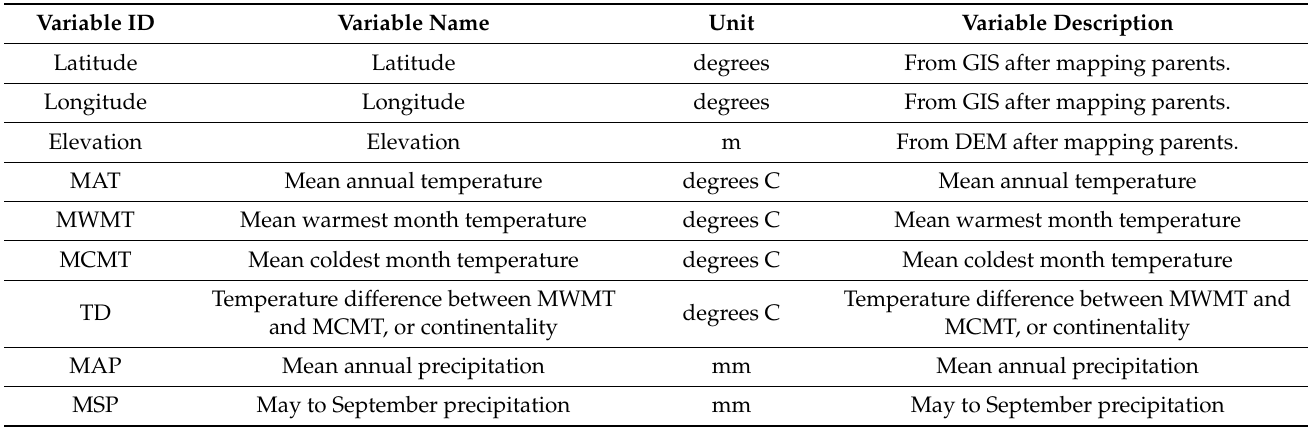
Table A2. Key to environmental traits. Variables included are: Variable name abbreviation (Variable ID), full variable name (Variable name), units of measurements (Unit), and a description of the variable (Variable